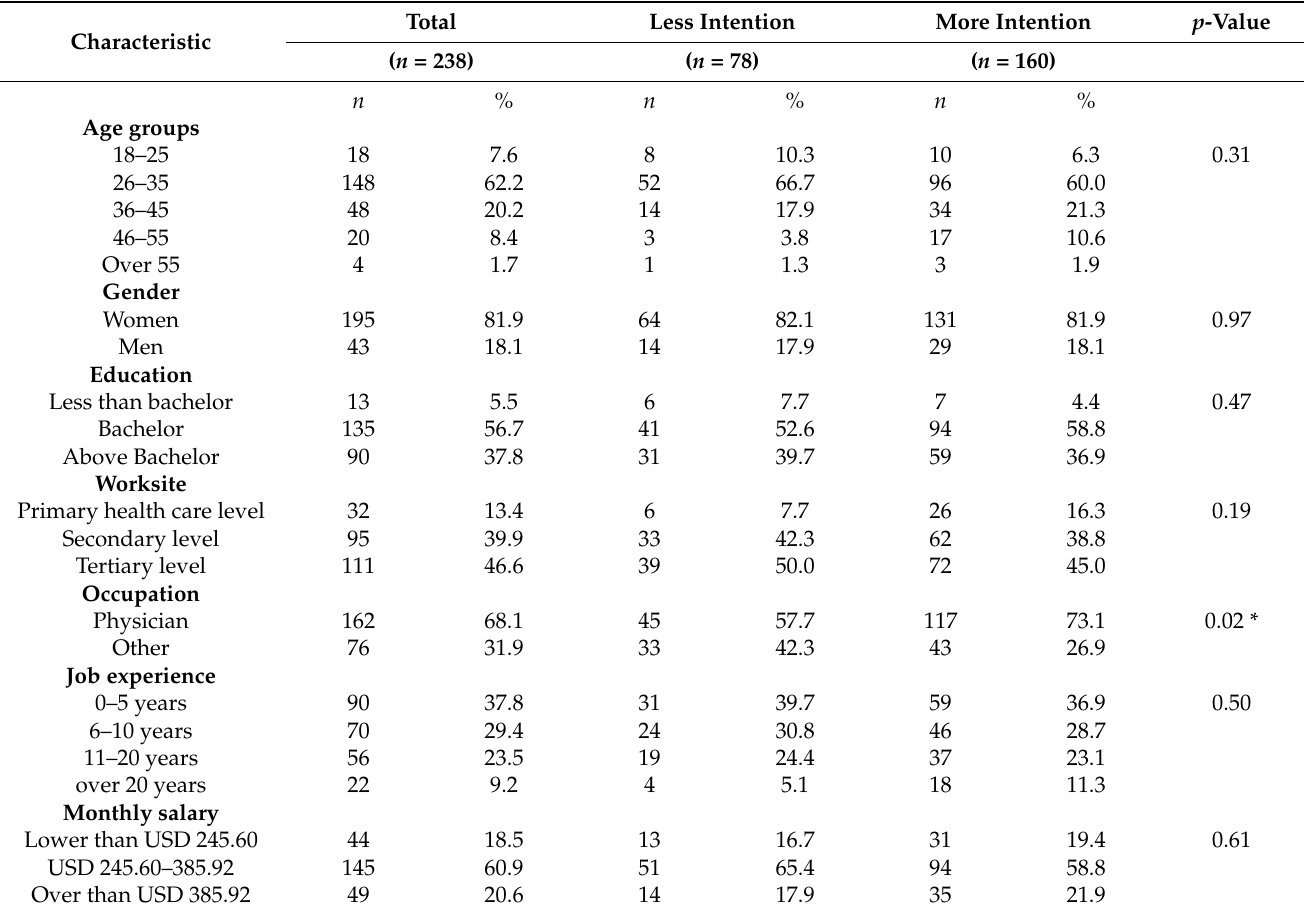
Table 1. Demographic characteristics of intention to be vaccinated against